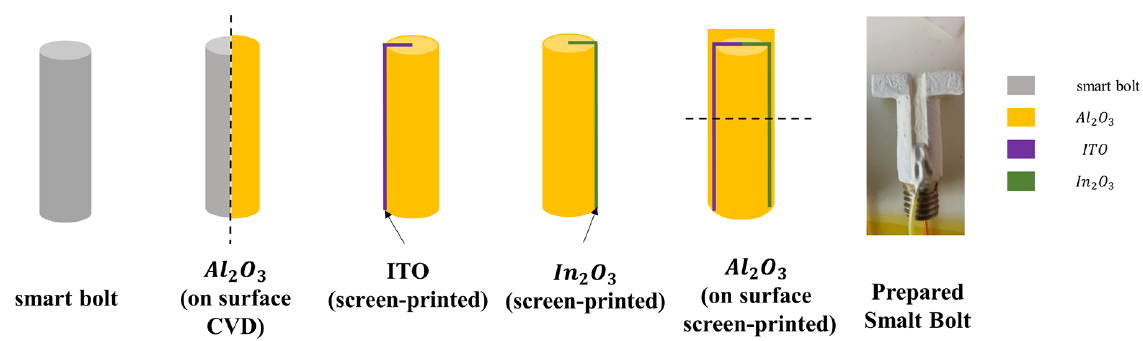
Figure 2. Intelligent bolt structure and process flow.